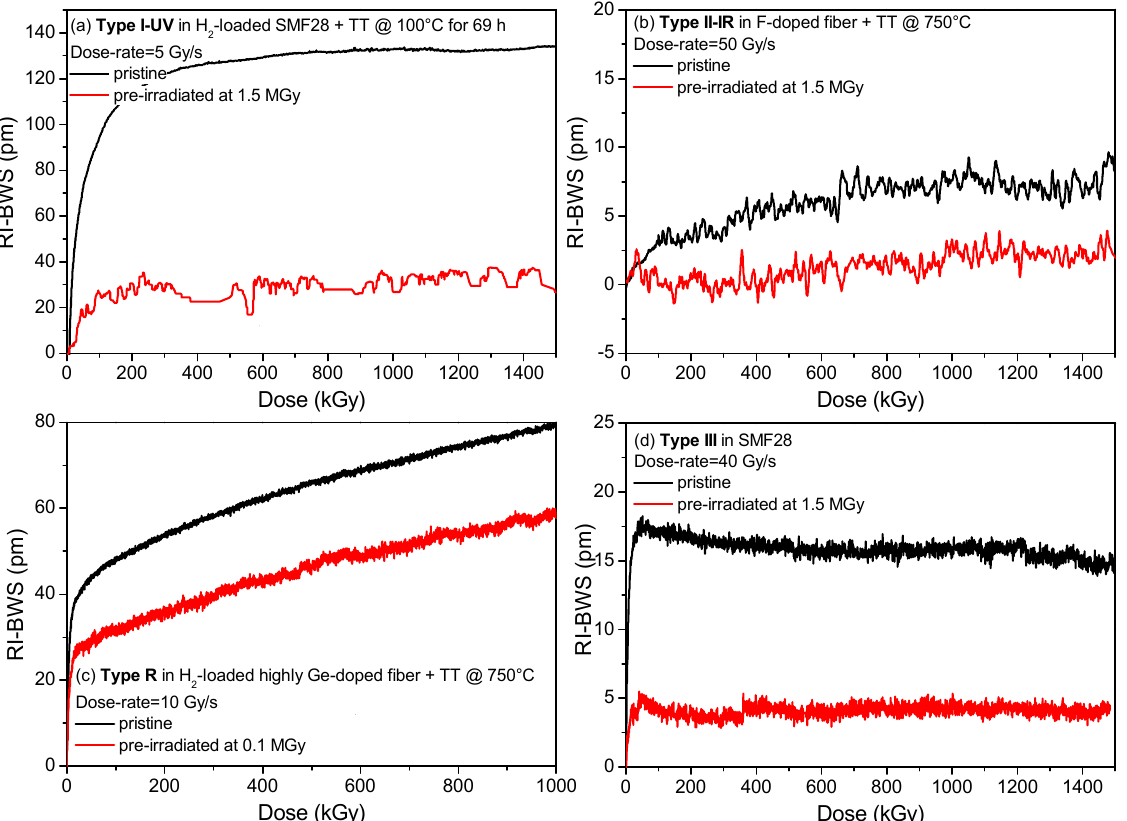
Figure 10. Effect of a pre-irradiation on the BWS induced by X-rays on different FBG types: ( a ) a type I FBG written in an H 2 -loaded SMF28 fiber with a UV CW laser (at 244 nm, power of 120 mW); ( b ) a type II FBG in an F-doped fiber with an fs-IR laser (at 800 nm, a pulse width of 150 fs, and pulse energy of ~500 µ J); ( c ) type R FBGs written in H 2 -loaded highly Ge-doped fiber and regenerated at 750 ◦ C; ( d ) a type III in the SMF28 fiber written PbP with an fs-IR laser (at 800 nm, a pulse width < 120 fs, and pulse energy of 230 nJ). Data extracted from [83,86,88,89].